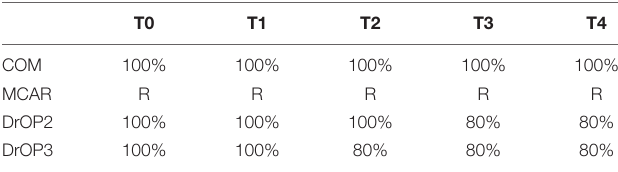
TABLE 6 | Percentage of students data used for analysis for each missing value